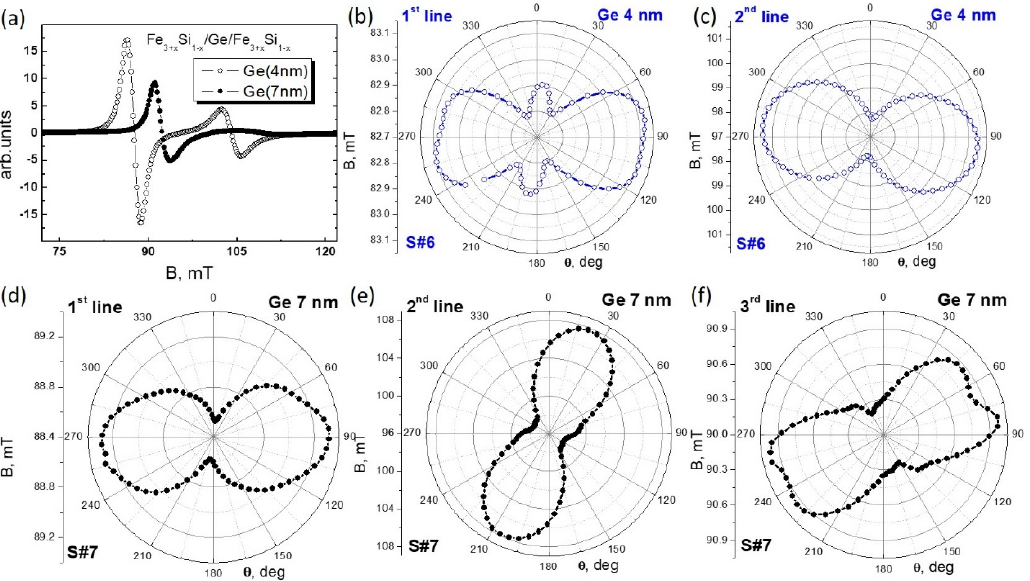
Figure 12. ( a ) FMR spectra of Fe 3+ x Si 1 − x /Ge(4nm)/Fe 3+ x Si 1 − x ( a ) and Fe 3+ x Si 1 − x /Ge(7nm)/ Fe 3+ x Si 1 − x struc- tures. Polar plots of angular dependences of 1st ( b ) and 2nd ( c ) lines of Fe 3+ x Si 1 − x /Ge(4nm)/Fe 3+ x Si 1 − x structure and 1st ( d ), 2nd ( e ), and 3rd ( f ) lines of Fe 3+ x Si 1 − x /Ge(7nm)/Fe 3+x Si 1 − x structure .